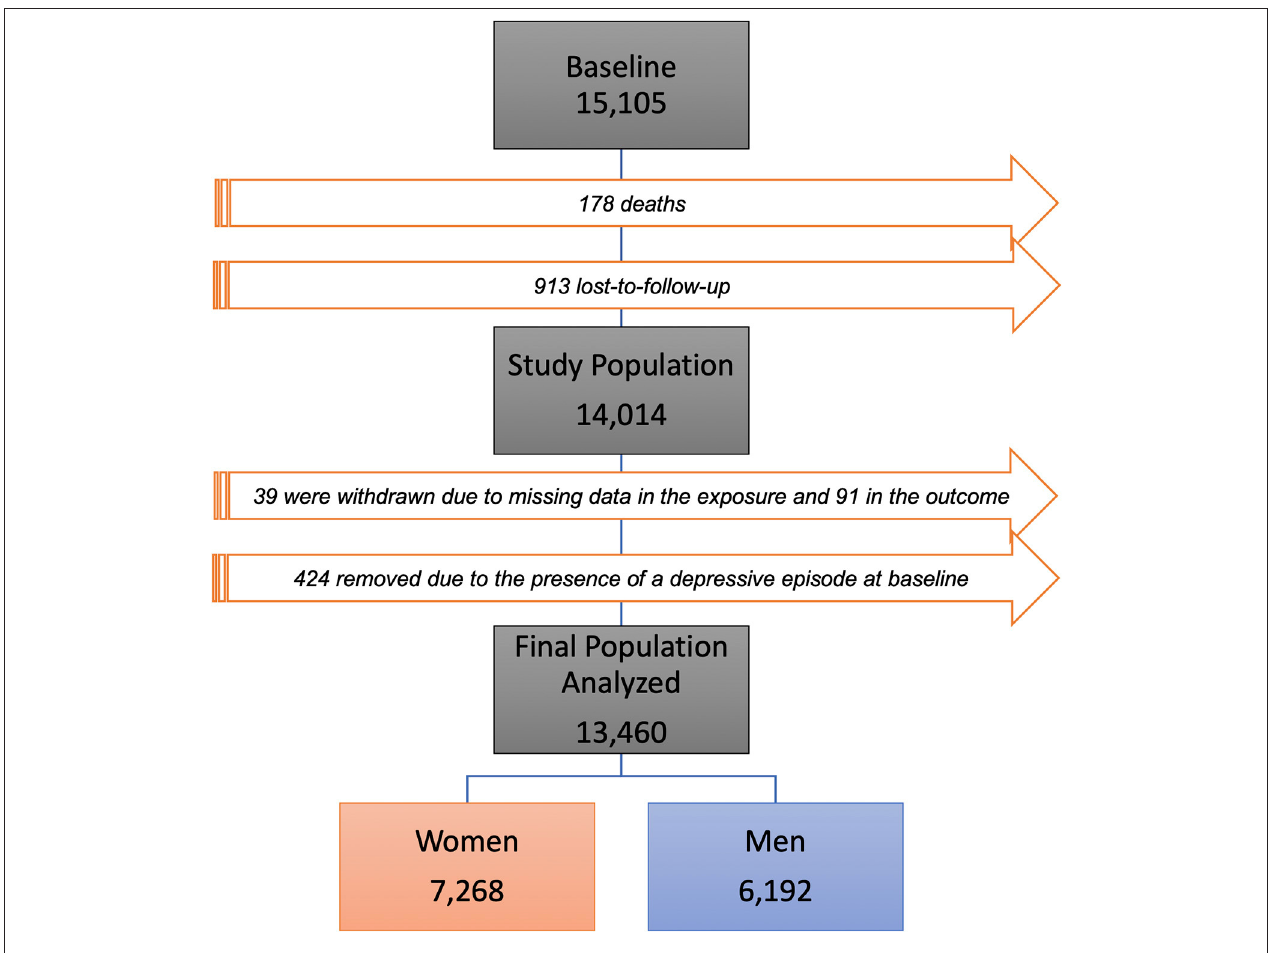
FIGURE 1 | Flowchart of the composition of the study population.